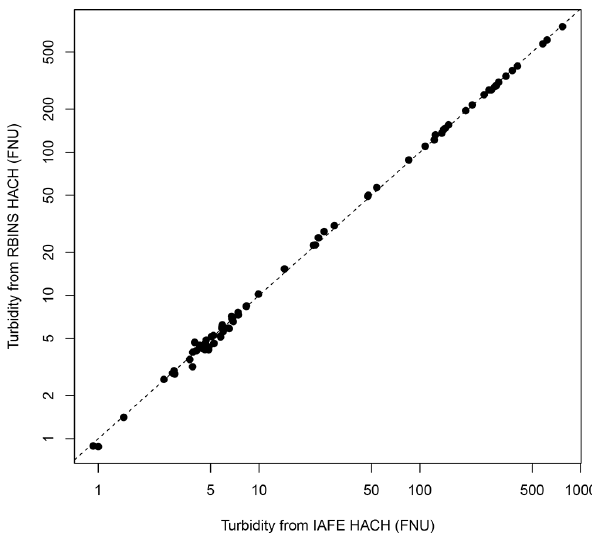
Figure 2. Comparison of simultaneous measurements of turbidity made from two different HACH instruments ( r 2 = 0 .